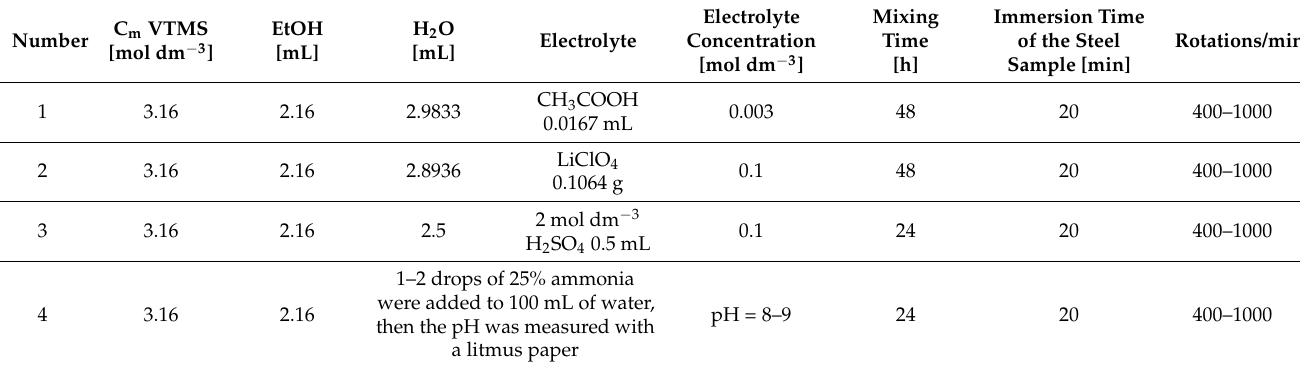
Table 3. Composition of coatings and mixing